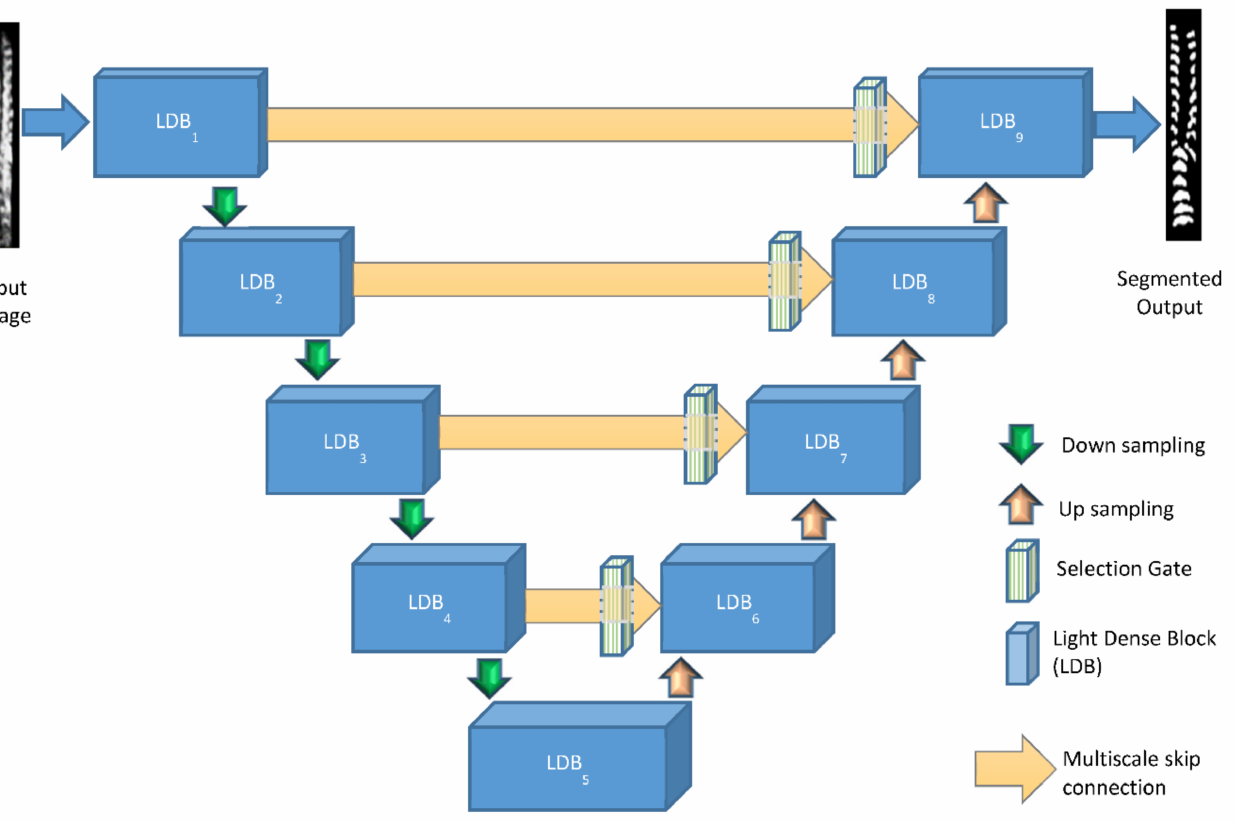
Figure 4. Proposed architecture of LDS